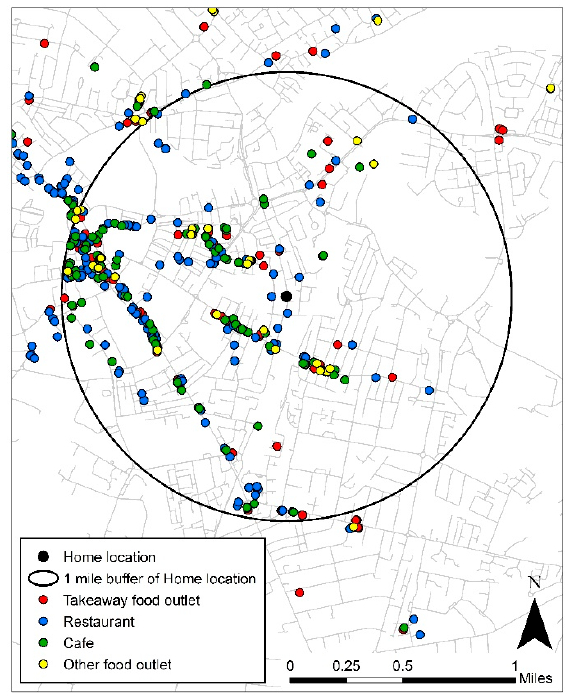
Figure 2. Depiction of how exposure was characterised as proportion of away from home food outlets to all food outlets around the home.